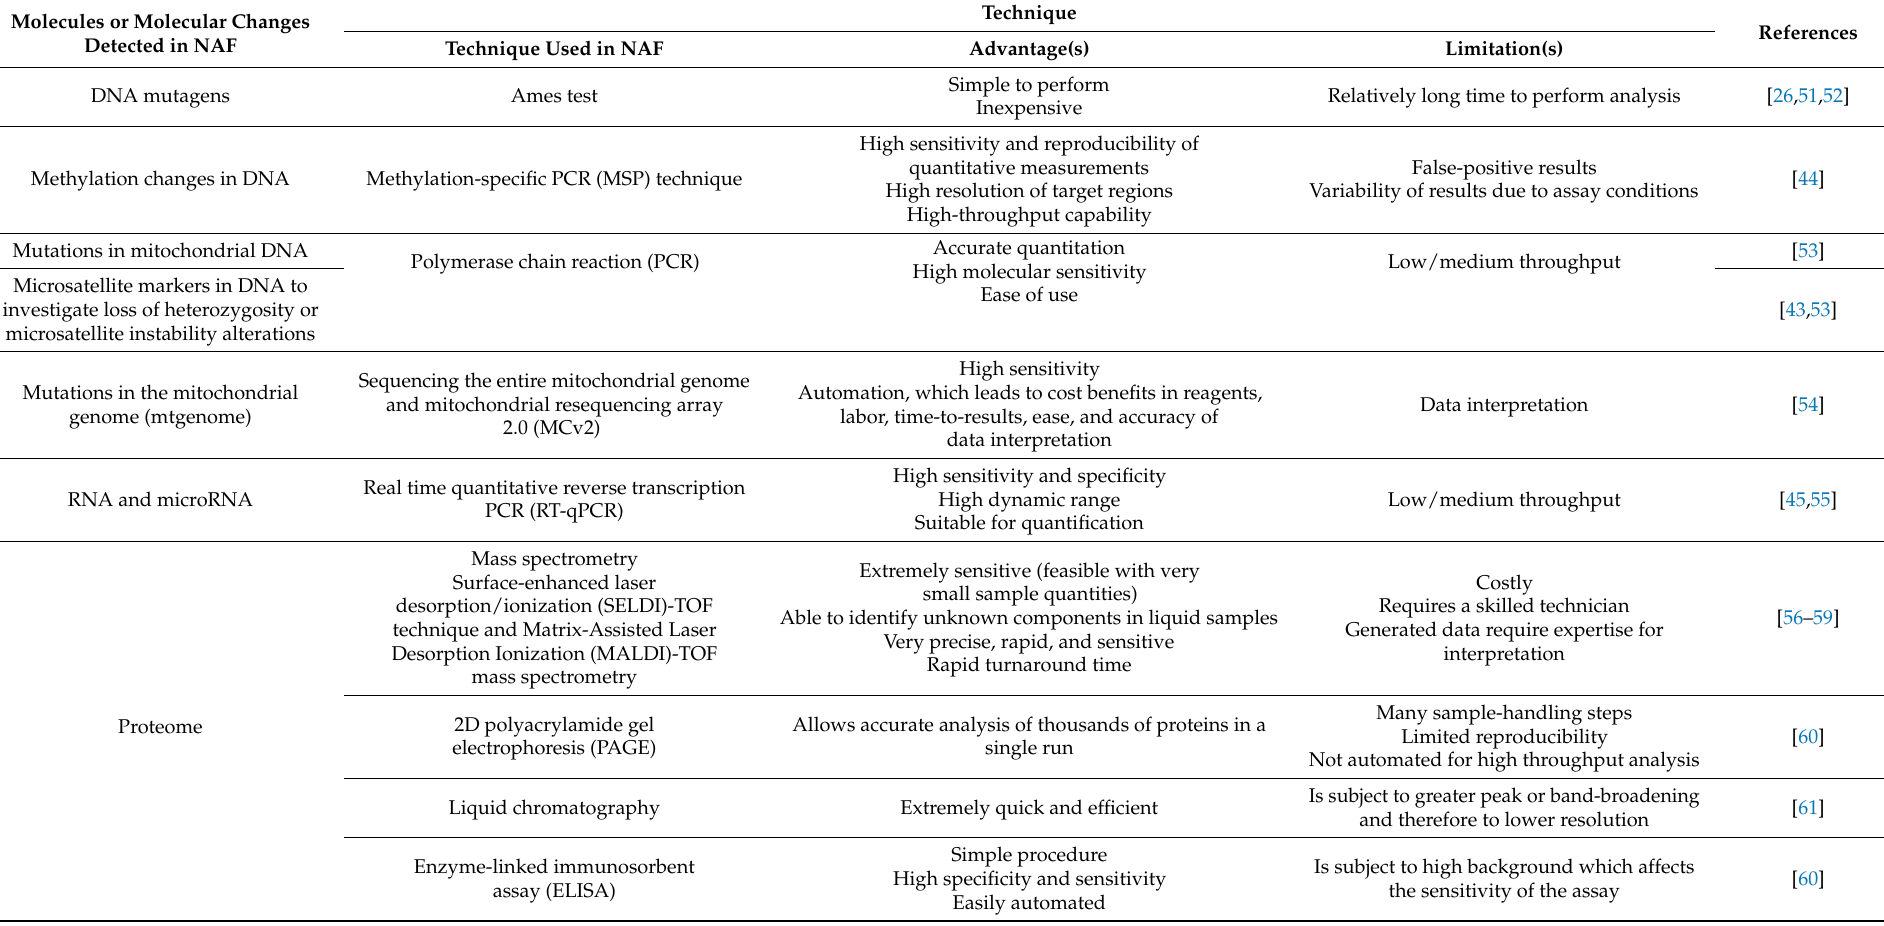
Table 2. Summary of molecules or molecular changes found in NAF and used techniques, their advantages, and limitations. This information was retrieved from